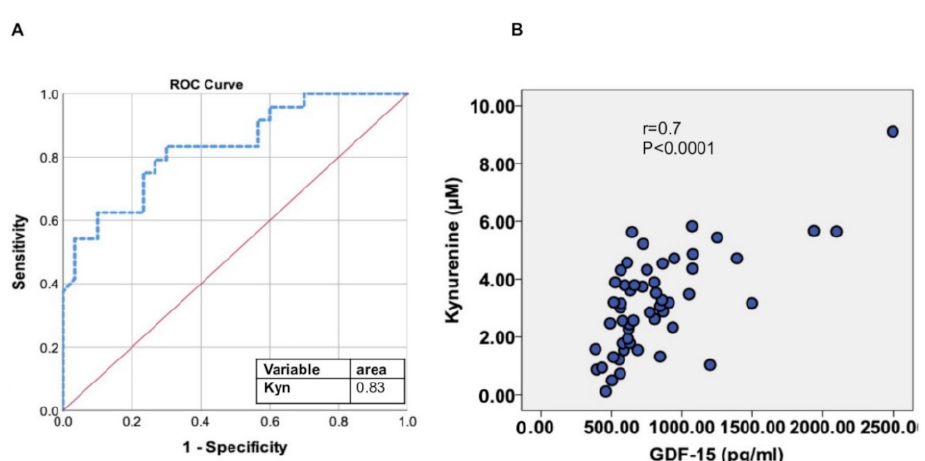
Figure 4. The relationship of Kyn to inflammatory biomarker (GDF-15) and its role in detecting RME. ( A ) The receiver operator characteristic (ROC) curve of Kynurenine to distinguish patients with RME of the left leg in flexion/muscle mass of the left leg. Area under the curve (AUC) is 0.83. ( B ) The relationship between GDF-15 and Kyn is shown in a simple regression (correlation)